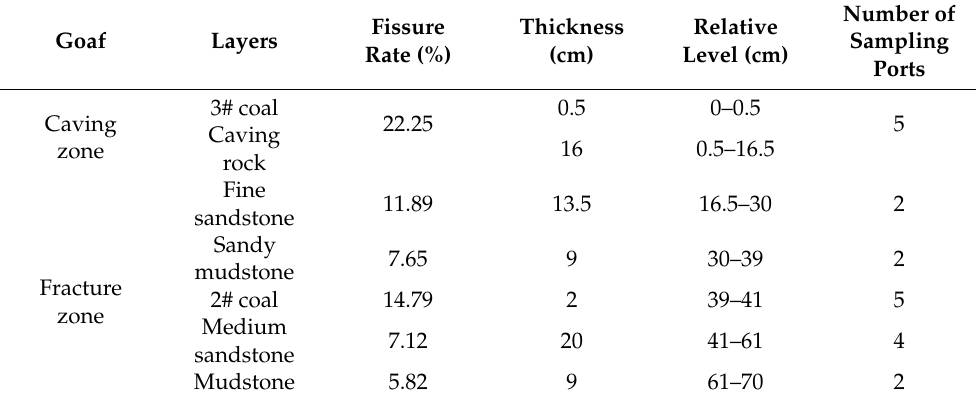
Relative Level (cm)